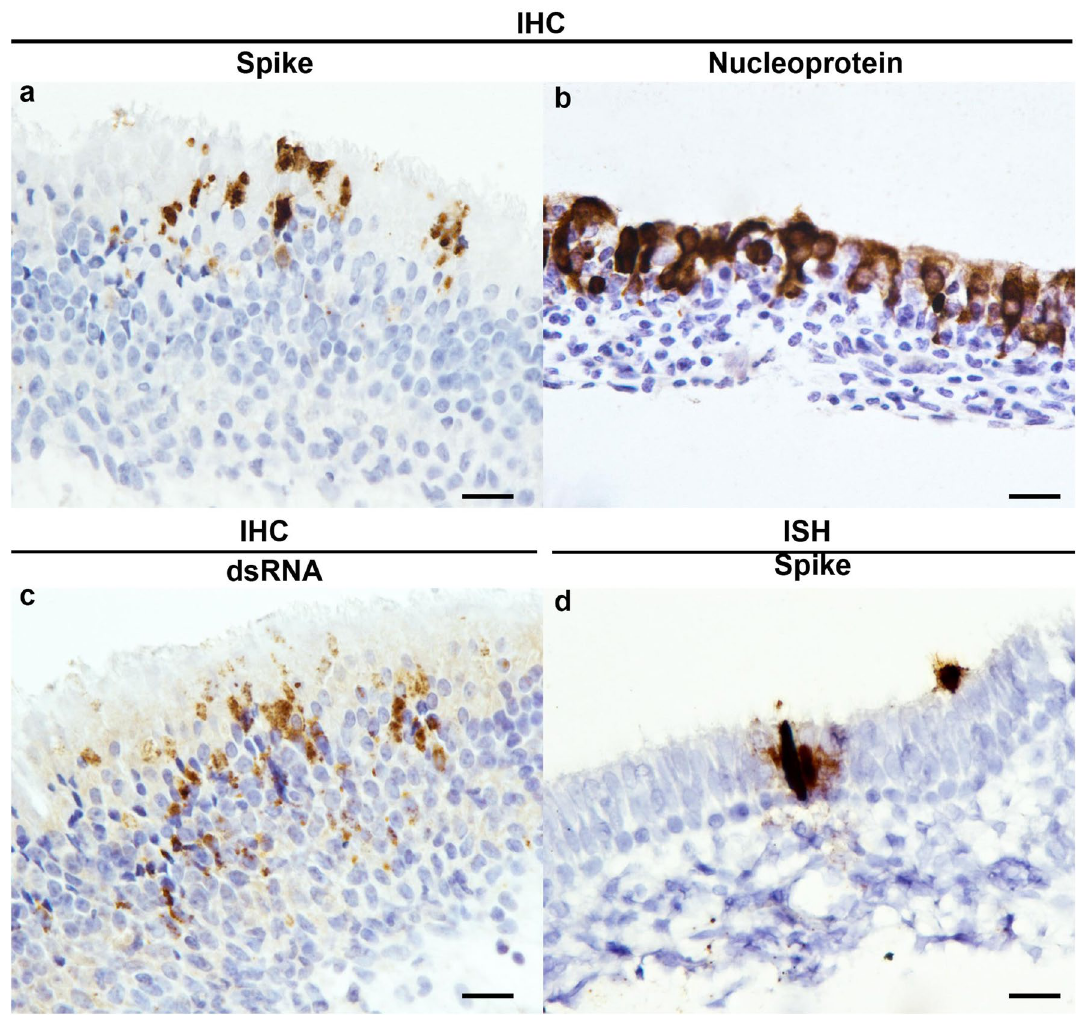
Figure 4. Immunohistochemistry and in situ hybridisation detection of SARS-CoV-2 and RNA on infected ferret tissues. Detection of spike protein (a) , nucleoprotein (b) and dsRNA antigens (c) and spike RNA (d) labelling. Tissue shrinkage artefact with ISH pre-treatment (d) . Scale bars, 20